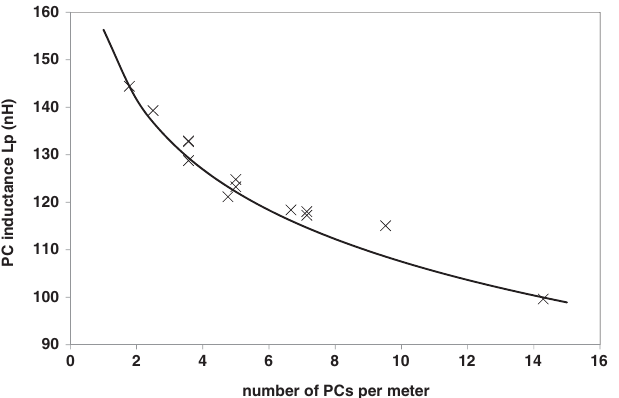
FIG. 7. PC inductance L per meter. The solid line is given by the L obtained from 3D simulations in quasistatic approximation.